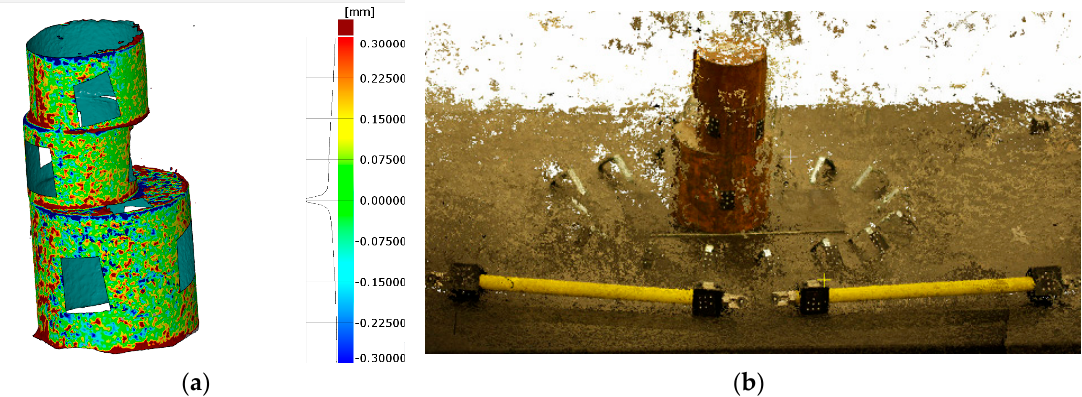
Figure 12. 3D representation of measured part in lab environment with coded target orientation approach: ( a ) surface point comparison against reference mesh; and ( b ) dense point cloud with color and texture information (full resolution).